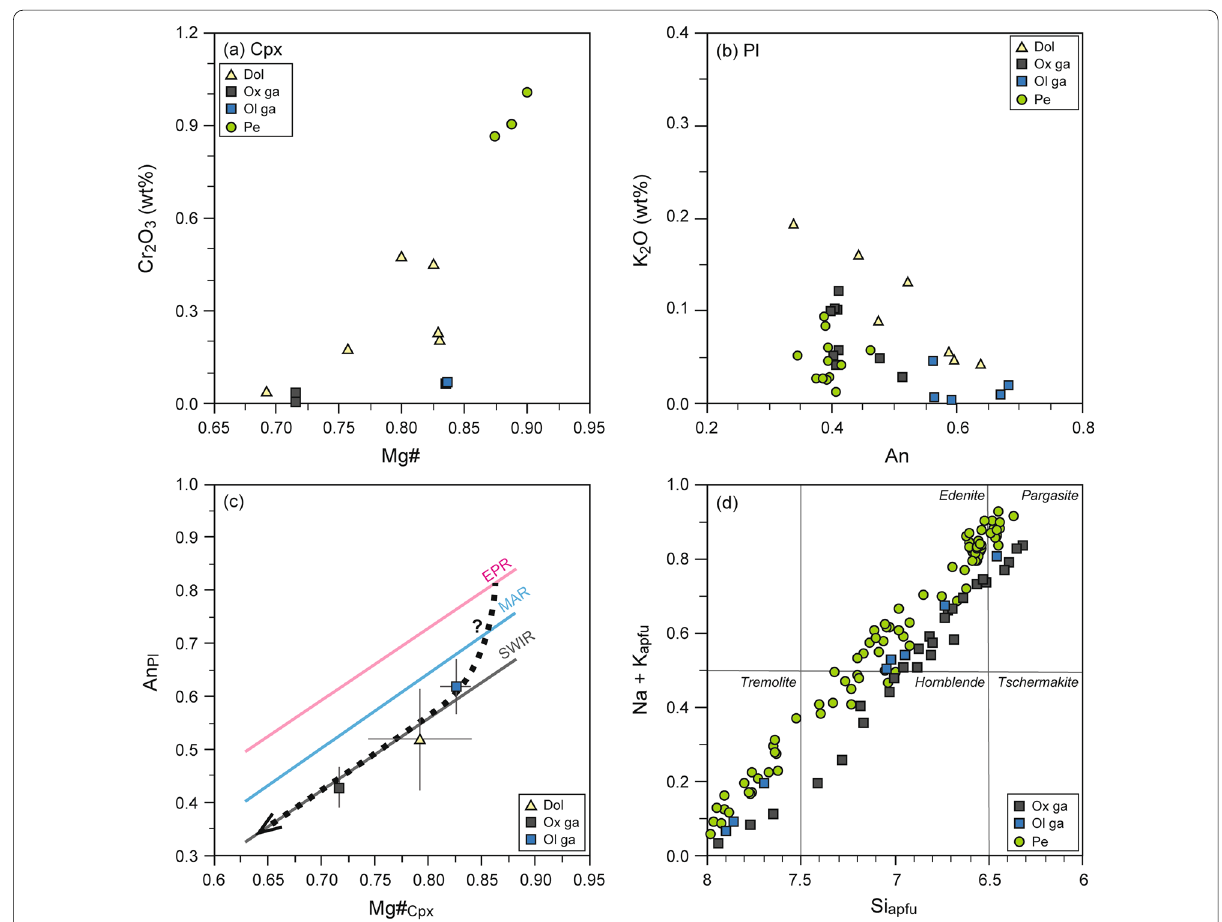
Fig. 6 Major‑element mineral compositions (in wt%). Average data with 1 SD in c . The lines in c represent compositional trends defined by lower crustal rocks from fast‑spreading EPR (pink), slow‑spreading MAR (pale blue), and ultraslow‑spreading SWIR (gray) by Basch et al. (2020). Amphibole classification in d is after Leake et al. (1997). Abbreviation: apfu atoms per formula unit, Cpx = ga olivine gabbro, Ox ga oxide gabbro, Pe peridotite, and Pl = = = =